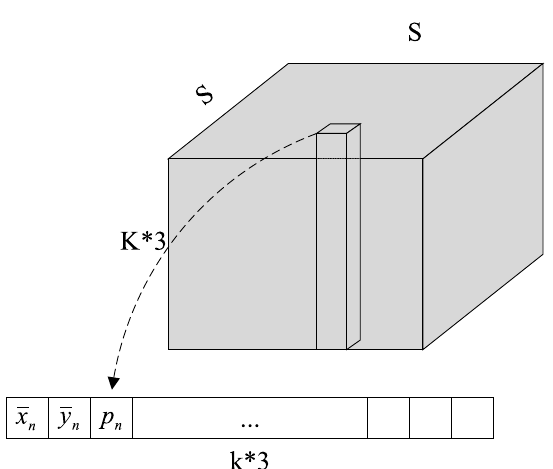
Fig. 7 Grid-encoding positional